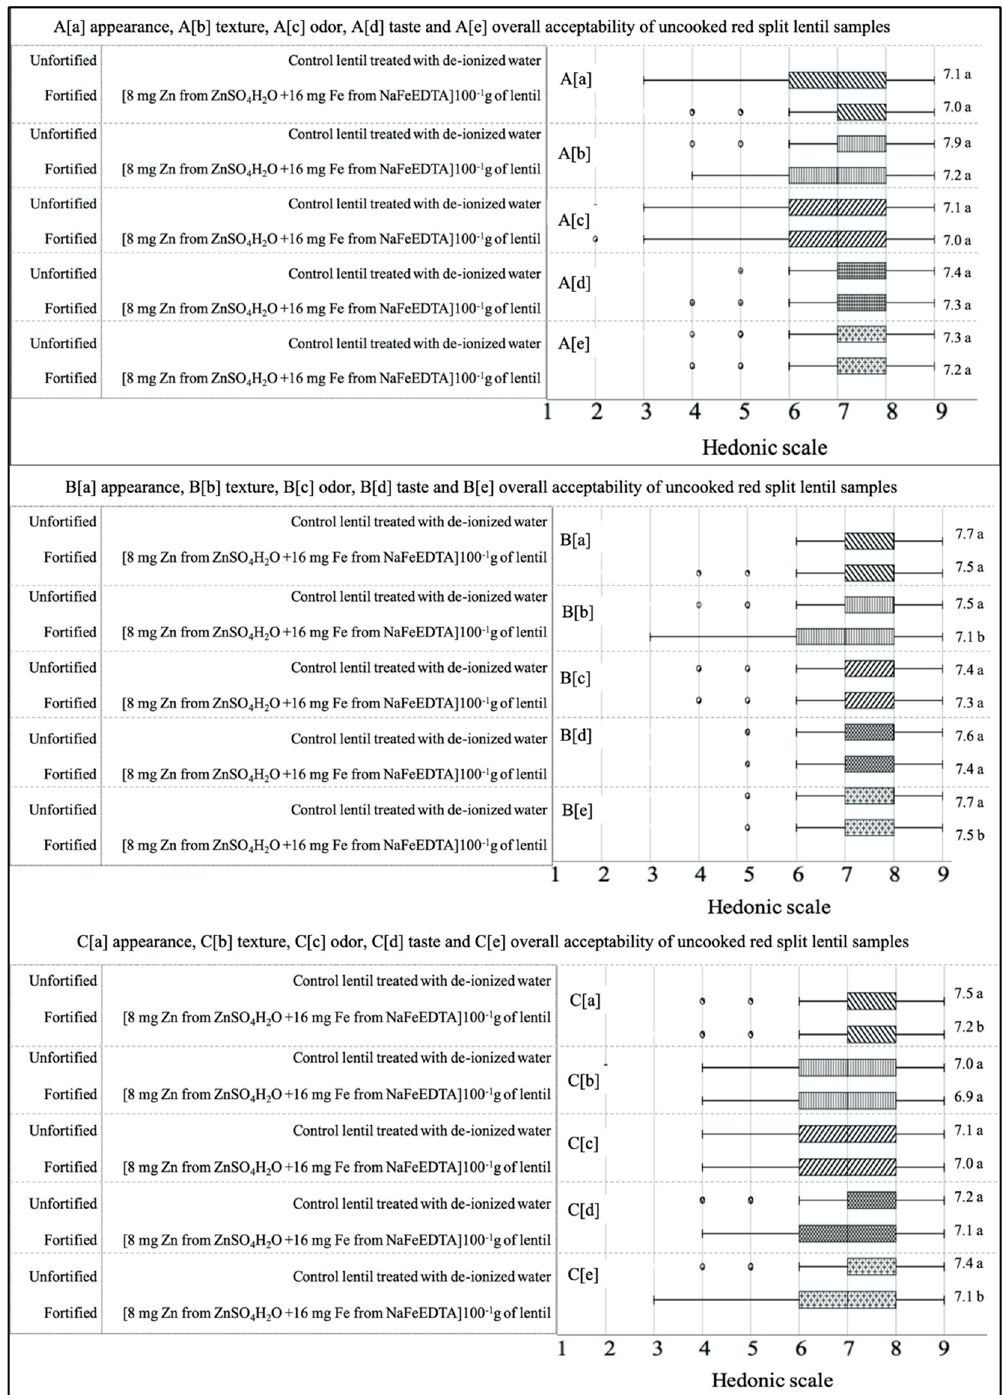
Figure 4. Box plot analysis of hedonic scores (1 = dislike extremely to 9 = like extremely) for two cooked lentil dal samples [unfortified control lentil polished with 0.5% canola oil; dual-fortified with 8 mg Zn from ZnSO 4 H 2 O + 16 mg Fe from NaFeEDTA (100 − 1 g of lentils) for each of the three lentil product types—red football ( A ) red split ( B ) and yellow split ( C ). Samples were evaluated for appearance ( A – C ( a )), texture ( A – C ( b )), odor ( A – C ( c )), taste (( A – C )( d )), and overall acceptability ( A – C ( e )), by 196 panelists in Bangladesh. Di ff erent letters after mean values in the right column indicate significant di ff erences between two samples within each attribute. Each box plot displayed the distribution of data for each sample type separately based on a five-number summary, “minimum”, first quartile (Q1), median, third quartile (Q3), and